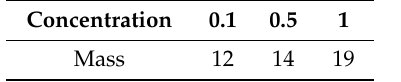
Table 2. The mass of the deposit (in mg) for the three different concentration solutions (in M). Concentration 0.1 0.5 1 Mass 12 14 19